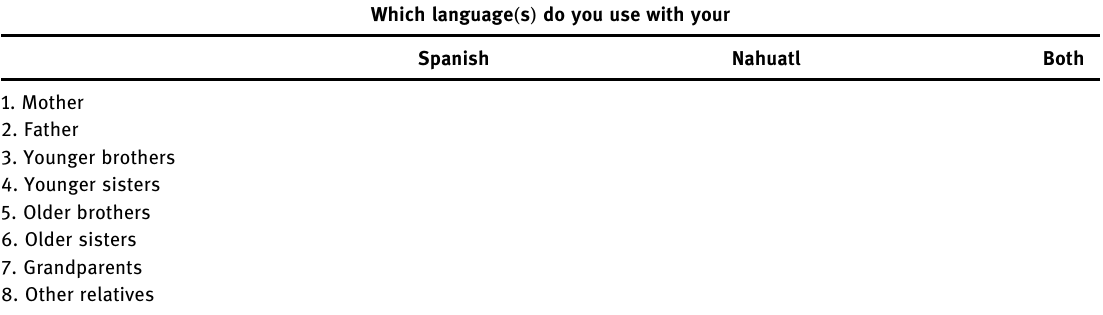
Table 2: Linguistic questionnaire II